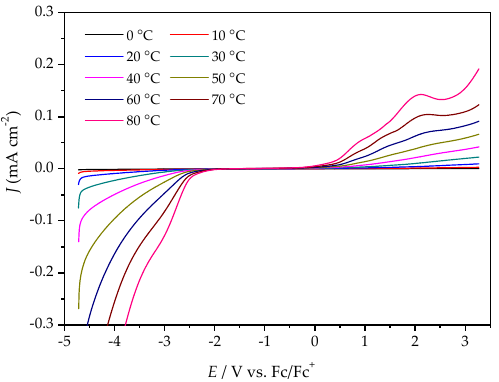
Figure 5. LSV of [P 4,4,4,8 ][BMB] at a GC electrode, different temperatures and a scan rate of 20 mV s −1 .